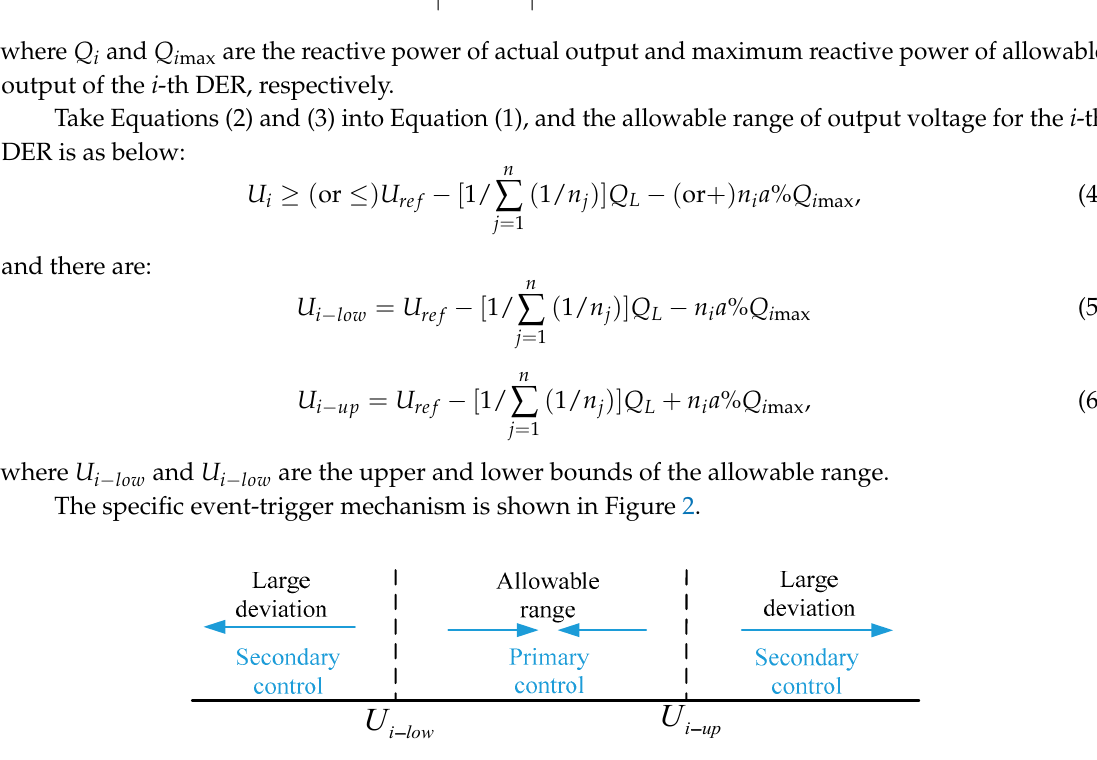
Figure 2. The proposed event-trigger mechanism on voltage control strategy.